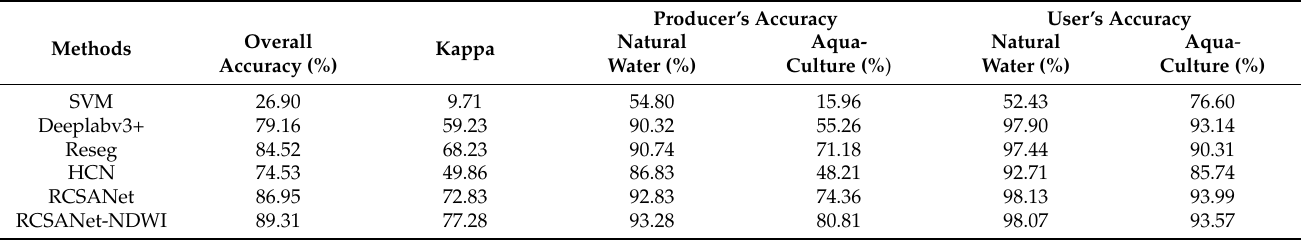
Table 3. Performance comparison of different methods for semantic segmentation of aquaculture ponds in Part 1 of the experiments